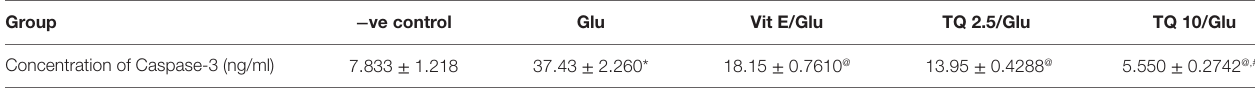
TaBle 5 | Effects of Glu, Vit E/Glu, TQ 2.5/Glu, and TQ 10/Glu on Casp-3 level. group − ve control glu Vit e/glu TQ 2.5/glu TQ 10/glu Concentration of Caspase-3 (ng/ml) 7.833 ± 1.218 Glu was injected i.p. as a single dose for 7 days. TQ and Vit E were injected as a single dose for 7 days. Animals in each group were subjected to the neurobehavioral tests before being sacrificed. The brains were isolated and homogenized as 10% homogenate in 0.1 M PBS then centrifuged, and supernatants were used in the Casp-3 ELISA kit. Statistical analyses of mean Casp-3 level were performed using ANOVA followed by Tukey’s multiple comparison tests, by graph pad prism 5. Each value represent the mean value of 12 rats